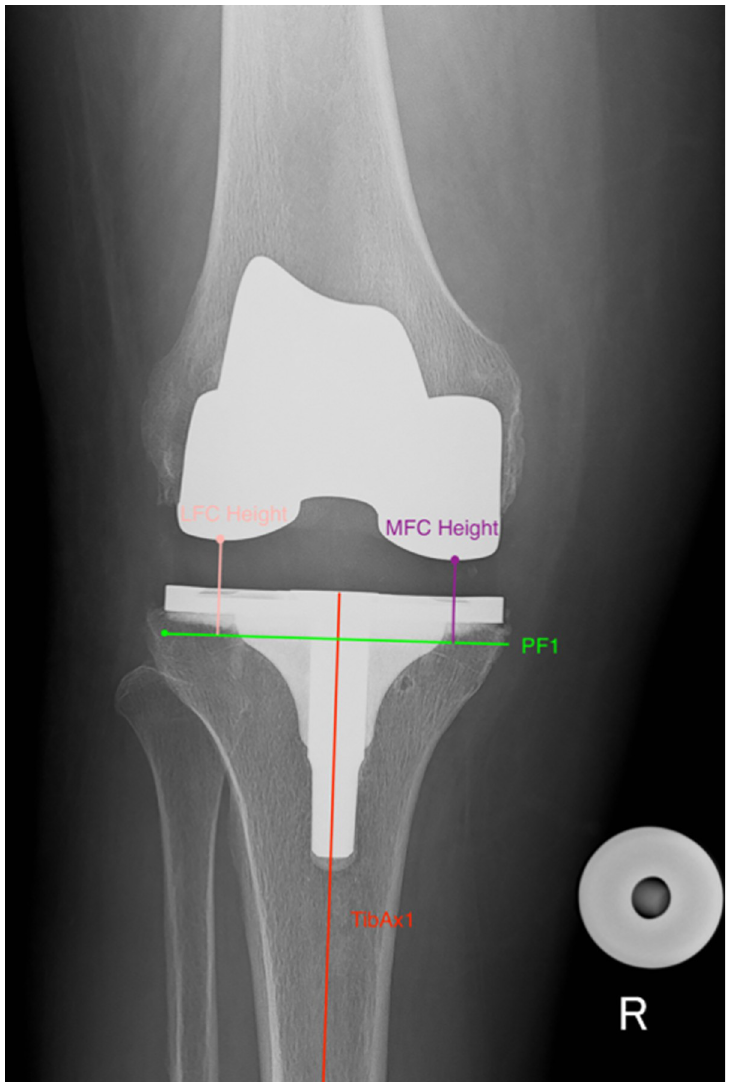
Pre (cid:0) operative joint line height ð mm Þ ¼ Tibial Height ð on less affected side Þ þ Femoral Height ð on less affected side Þ 2 Post (cid:0) operative joint line height ð mm Þ ¼ Medial joint line height þ Lateral joint line height 2 Change in joint line height ð mm Þ ¼ Post (cid:0) operative joint line height (cid:0) pre (cid:0) operative joint line height